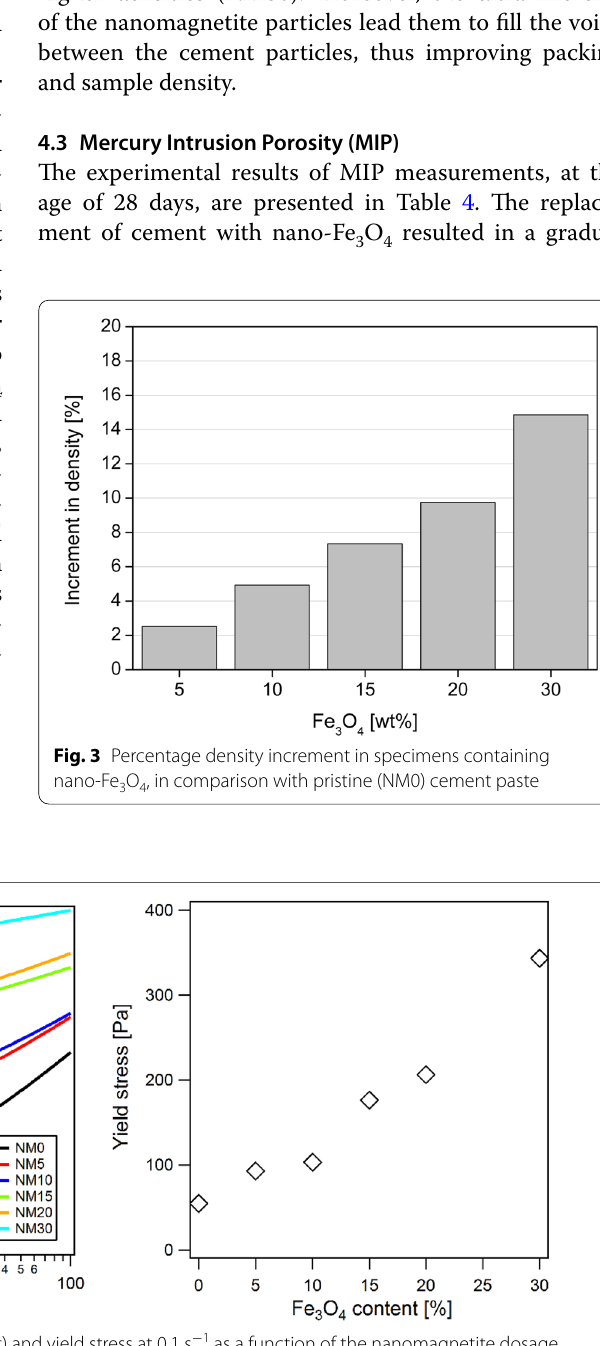
Fig. 2 Shear‑stress as a function of the shear rate of cement pastes (left) and yield stress at 0.1 s − 1 as a function of the nanomagnetite dosage (right)